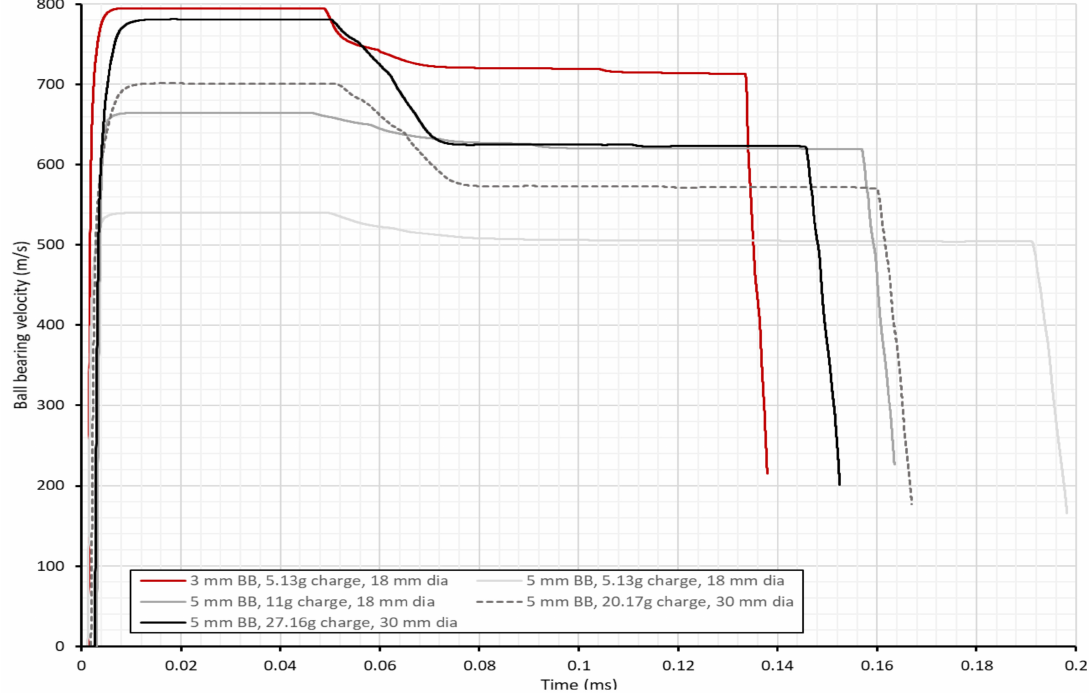
Figure 6. Simulated velocity–time histories for 3 mm and 5 mm diameter ball bearings at different charge masses, from detonation to impact